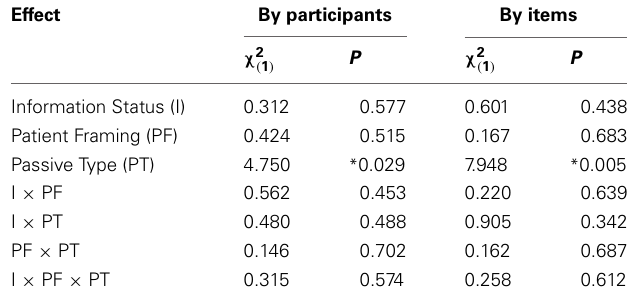
Table 10 | Generalized-Score Chi-Squares from binary logistic GEE analyses, predicting the likelihood of agentive by-phrase inclusion by factor combinations of Information Status (given Agent or given Patient), Patient Framing (Agent-like or Patient-like), and Passive-type (be or